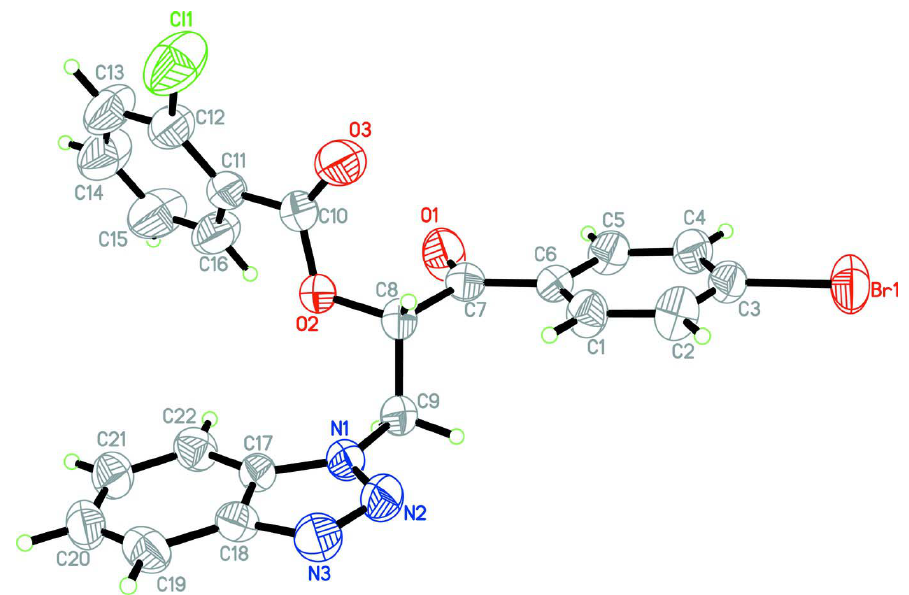
Figure 1 The molecular structure of the title compound, showing 50% probability displacement ellipsoids and the atom numbering scheme. Hydrogen atoms are represented by spheres of arbitrary